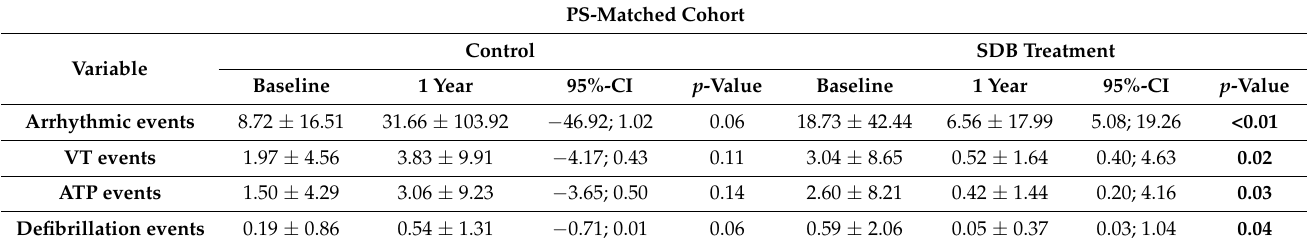
Table 3. 1-Year Outcome after SDB Treatment (PS-matched Table 3. 1 ‐ Year Outcome after SDB Treatment (PS ‐ matched cohort).